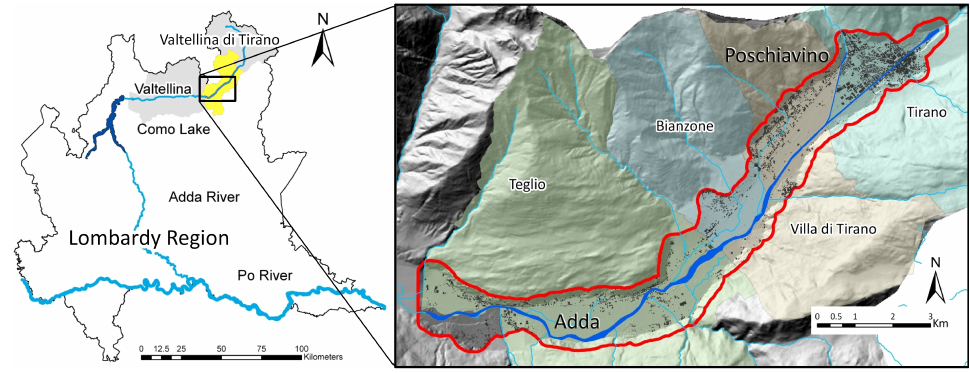
Fig. 1. Location of the study area, the southern part of Valtellina di Tirano in northern Italy, Lombardy